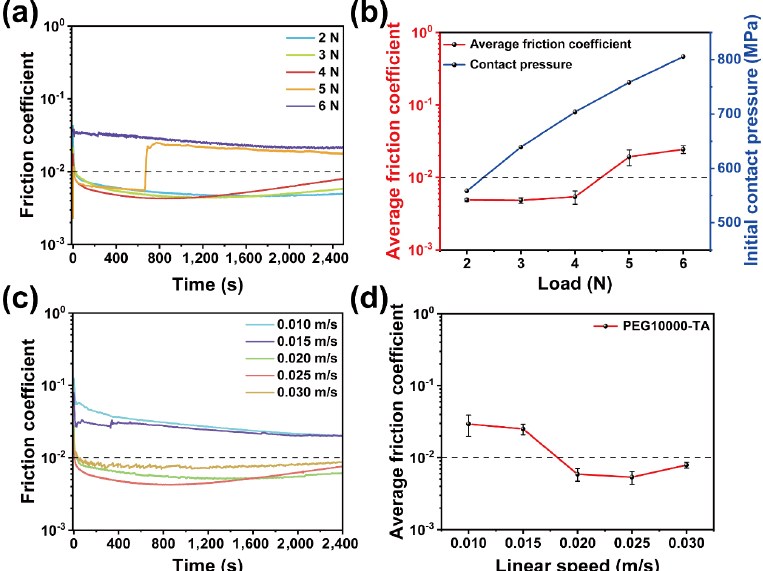
Fig. 5 In the case of PEG10000-TA lubrication: (a) Typical friction coefficient curve and (b) average friction coefficient and initial contact pressure under different applied loads with a maximum linear velocity of 0.025 m/s; (c) typical friction coefficient curve and (d) average friction coefficient at linear speeds of 0.010–0.030 m/s under a load of 4 N. The mass fractions of PEG10000 and TA in the lubricant used were 45 wt% and 2 wt%,